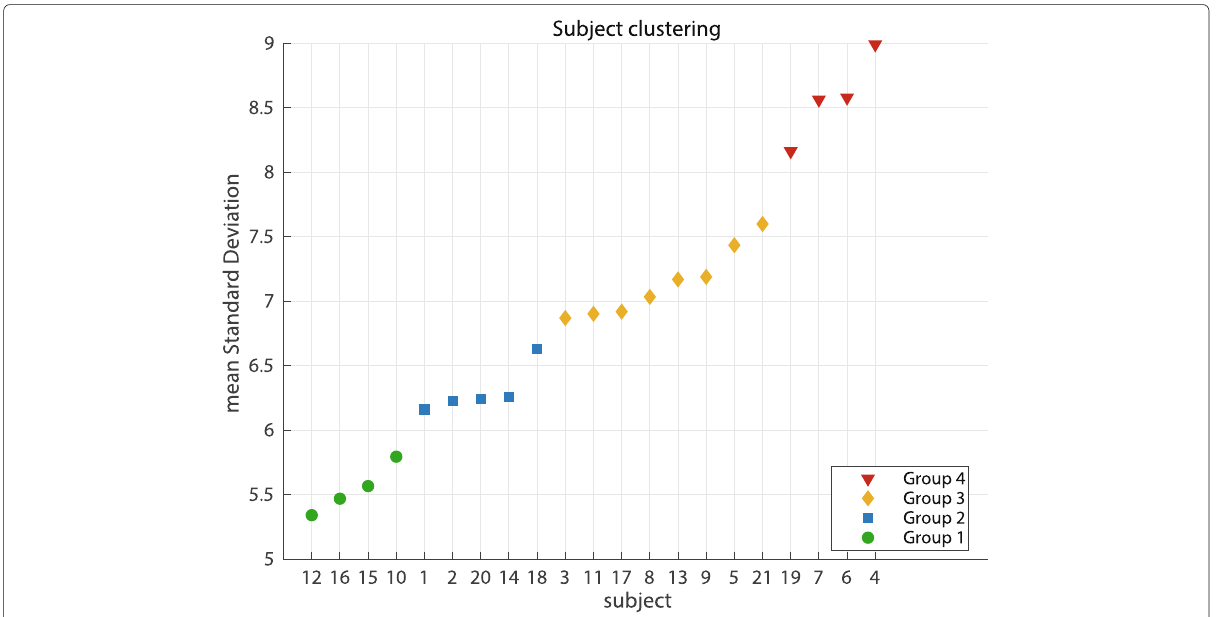
Fig. 6 Clustering of the subjects based on the standard deviation of the error of their answers